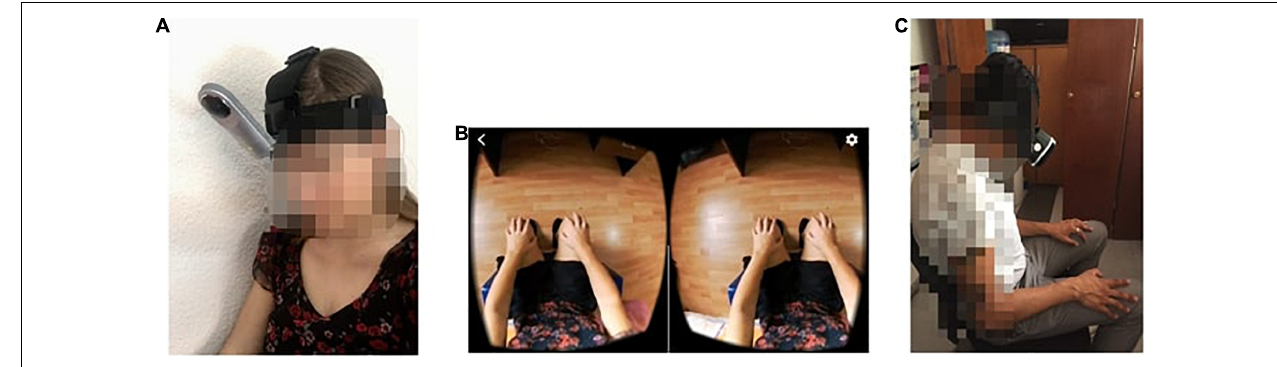
FIGURE 1 | The 360-degree video to induce the body-swap illusion. (A) Recording the video. (B) Female participant’s perspective. (C) Male participant doing the